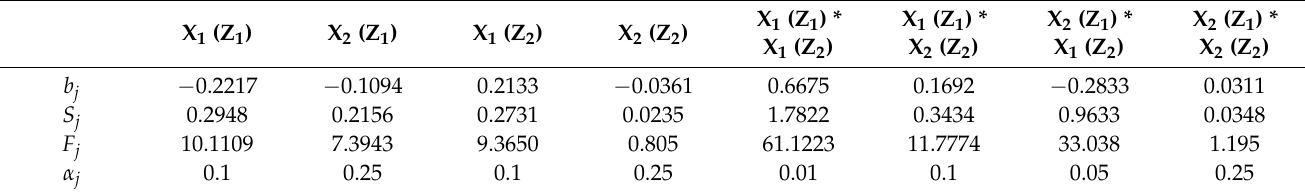
Table 4. Results of the regression